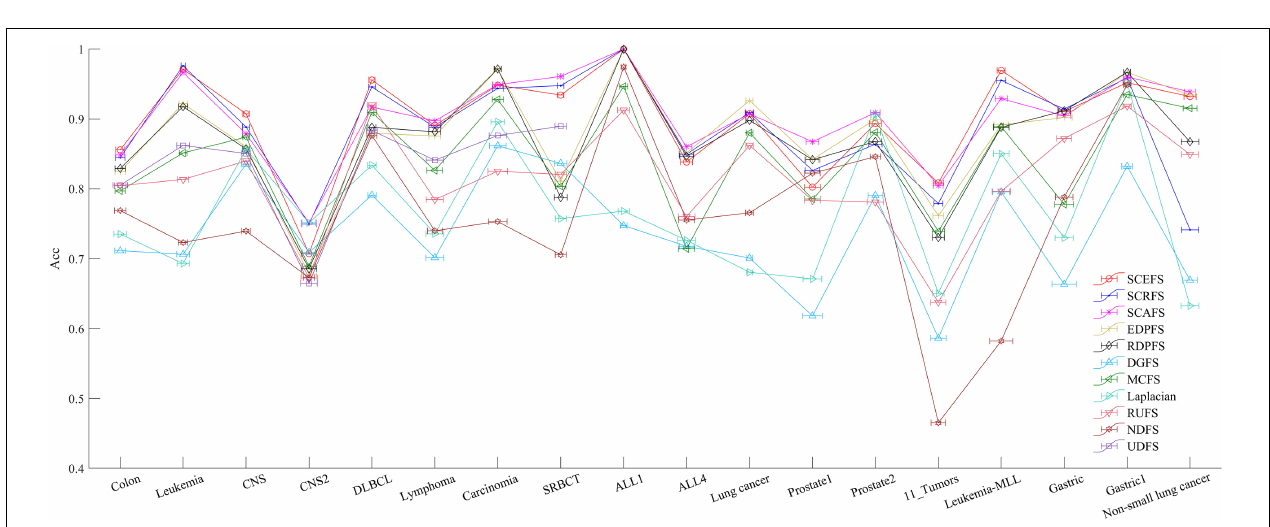
FIGURE 5 | The average accuracy (Acc) and F2 of all algorithms on three datasets using KNN classifier, (A) and (D) Leukemia, (B) and (E) ALL1, (C) and (F) Non-small lung cancer.